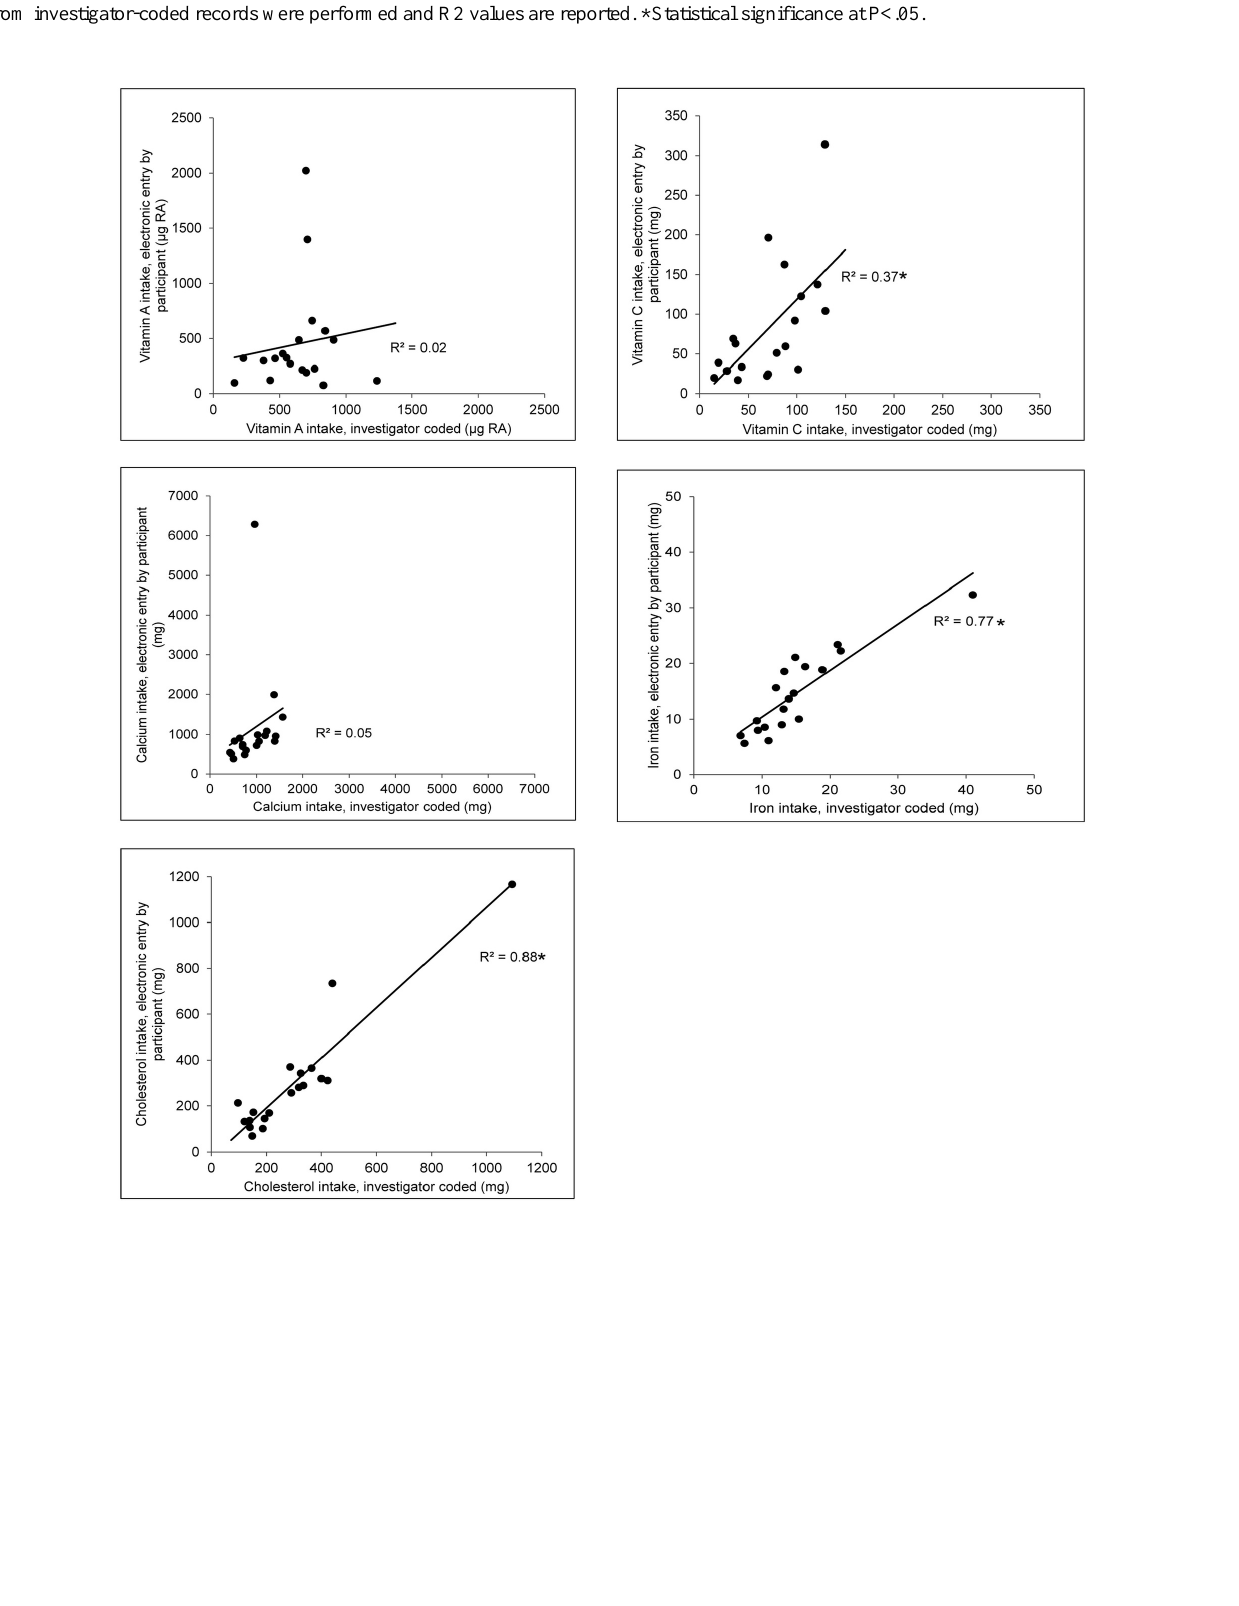
Figure 5. Plots comparing nutrient intakes estimated from 3-day diet records coded by investigator to the same 3-day diet records entered electronically: Comparing Nutrihand (black circle) to Grand Forks Research Analysis of Nutrient Data (GRAND). Each point represents mean of food records for 3 days for each individual (n=19). Regressions comparing intake estimates from Nutrihand (solid line) and Tap & Track (dashed line) to estimates obtained from investigator-coded records were performed and R2 values are reported. *Statistical significance at